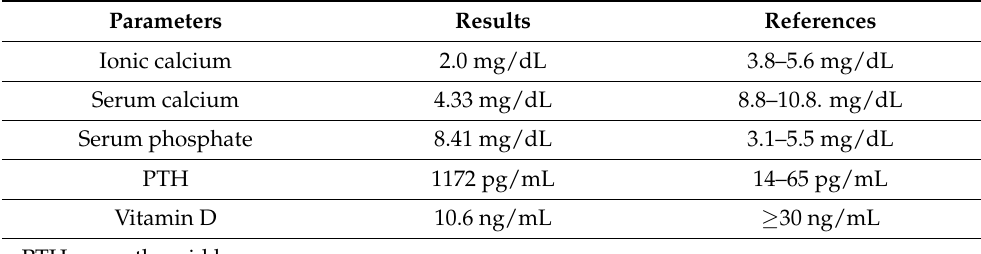
Table 3. Phospho-calcium balance.